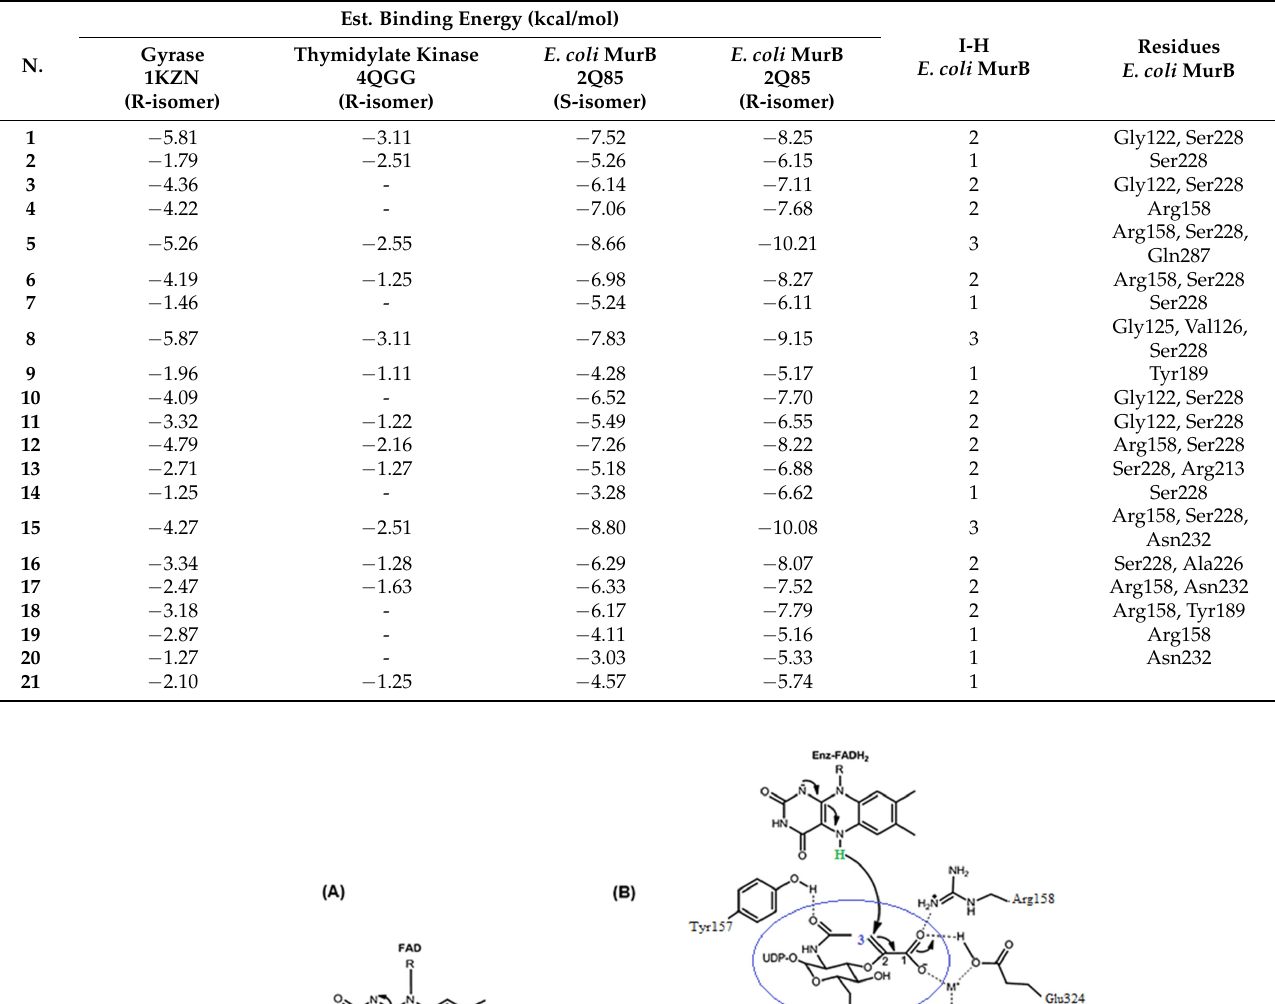
Table 5. Results of docking studies on antibacterial targets.